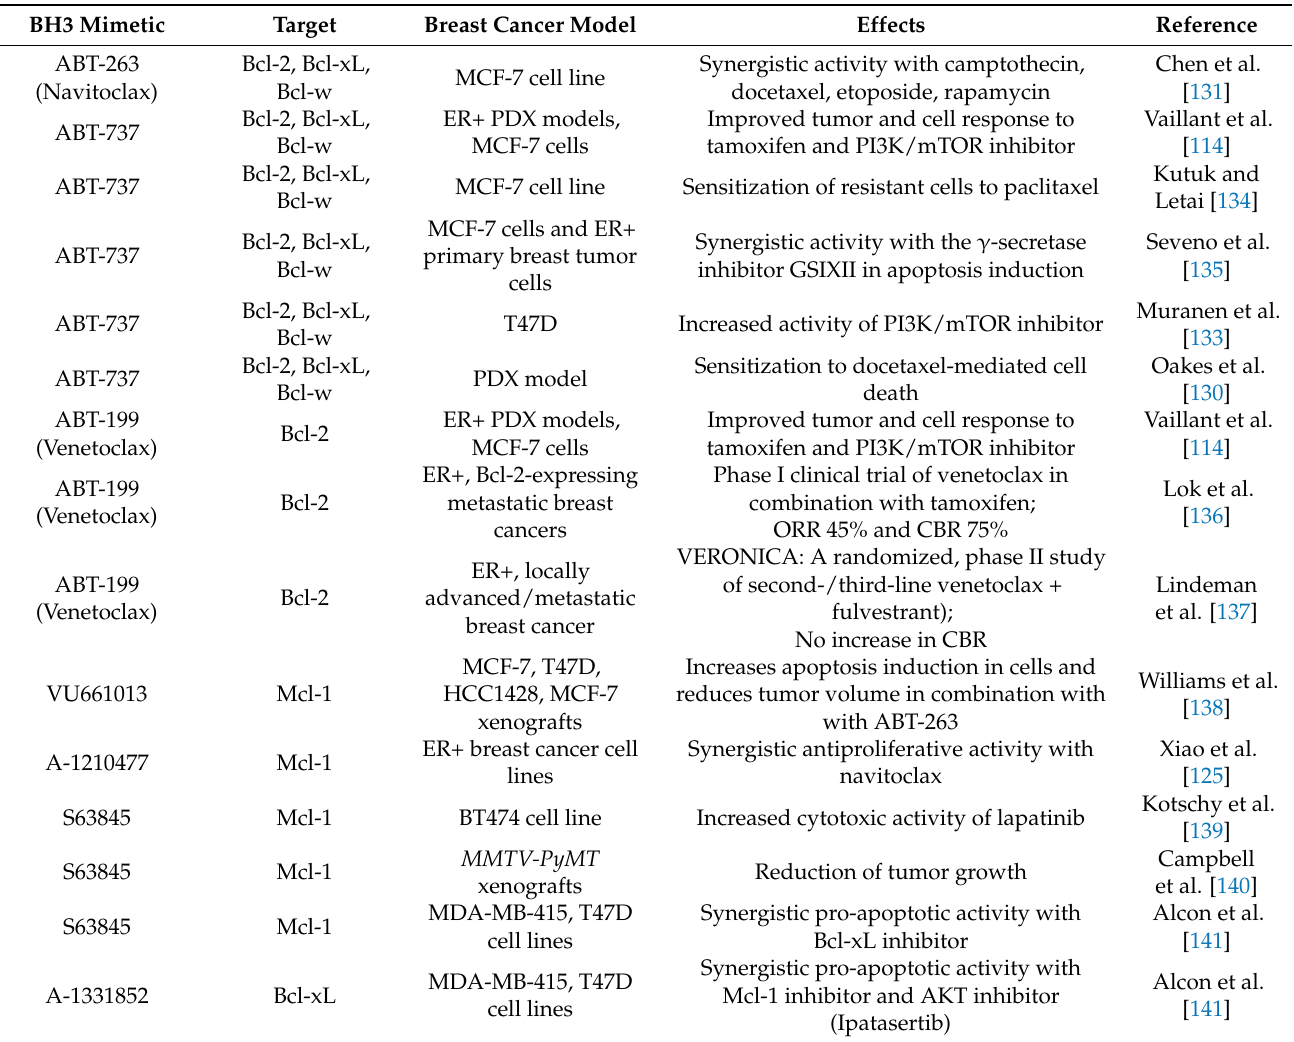
Table 1. Effects of BH3 mimetics in ER+ breast cancer